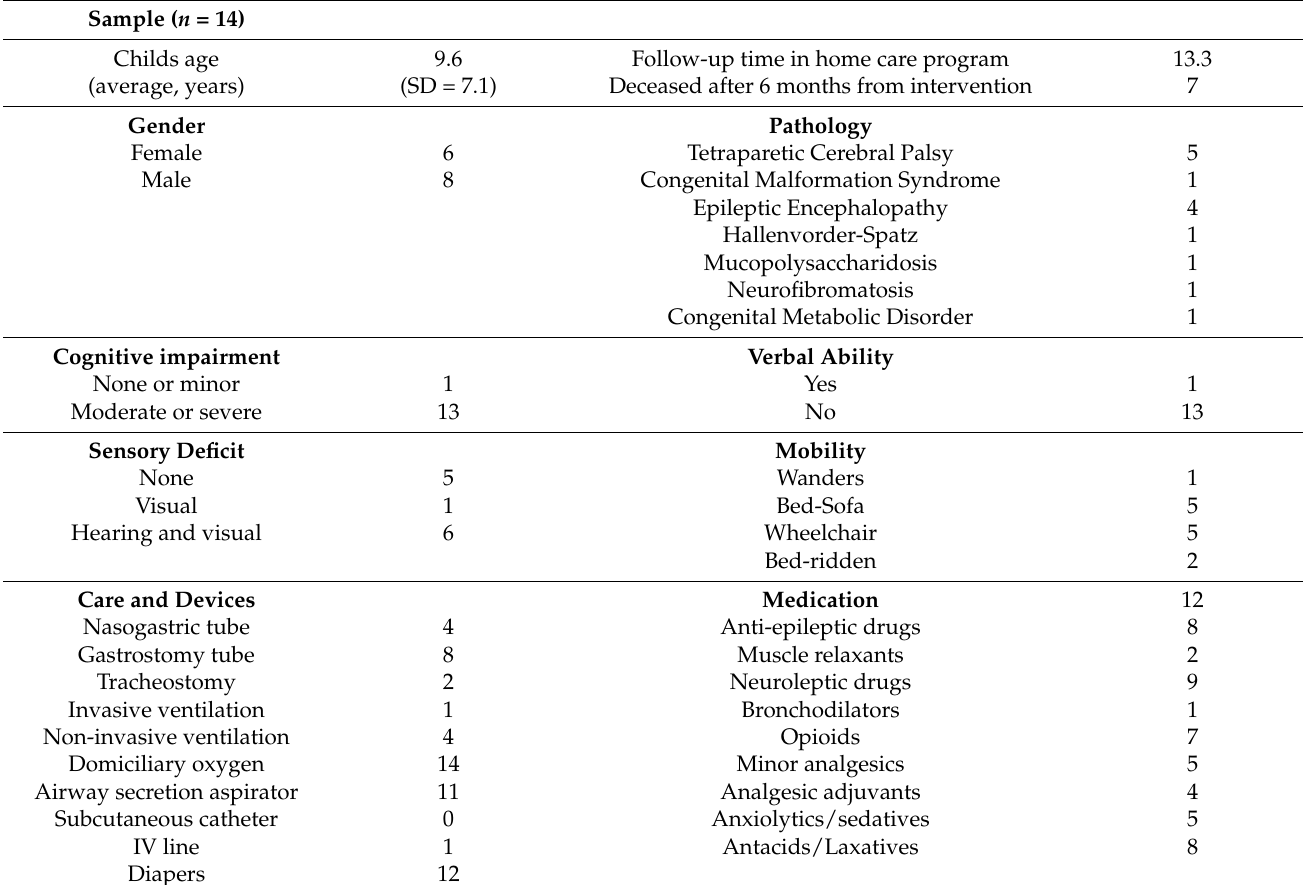
Table 3. Characteristics of the patients whose caretakers participated in the